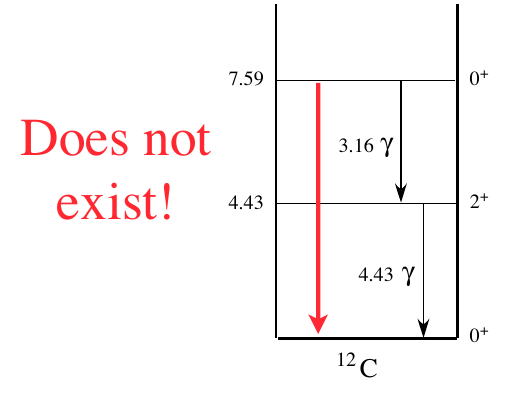
Figure 8.13: The status of the level structure of Figure 8.14: The clear evidence for the two groups Figure 9: The structure of 12 C after Beghian et al dis- covery. The direct transition from the 7.59MeV to the ground state is